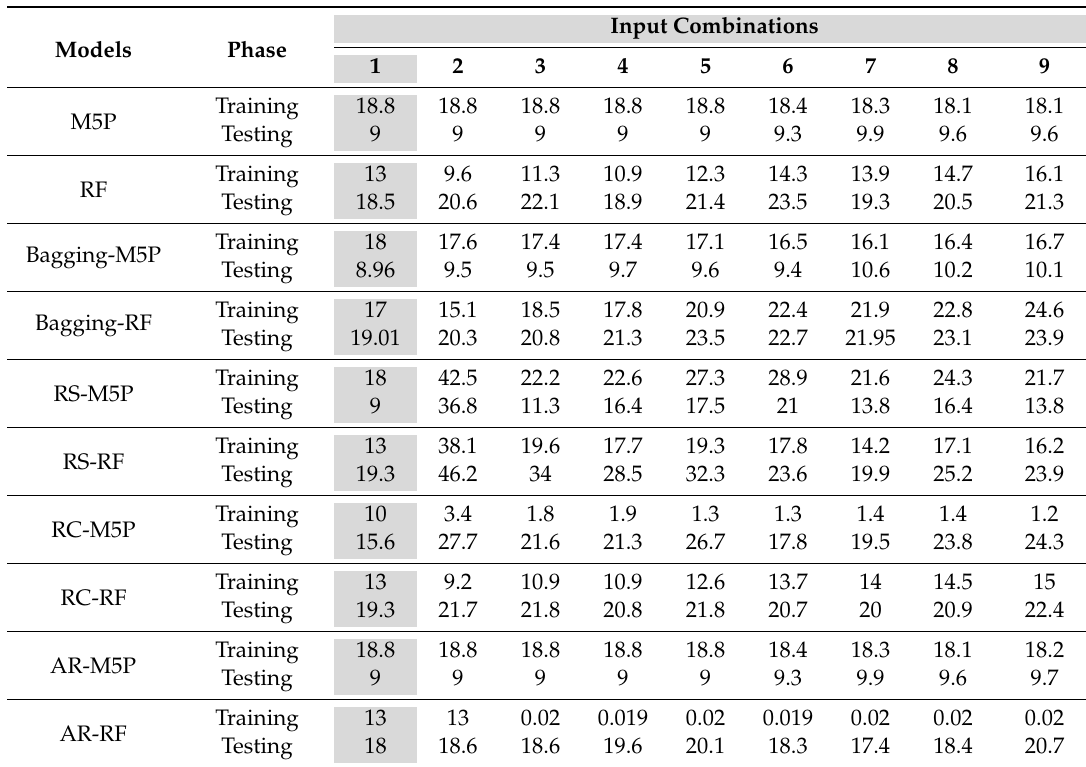
Table 4. Training and testing-phase RMSE ( µ s / cm) values. The testing values were used to identify the most e ff ective input